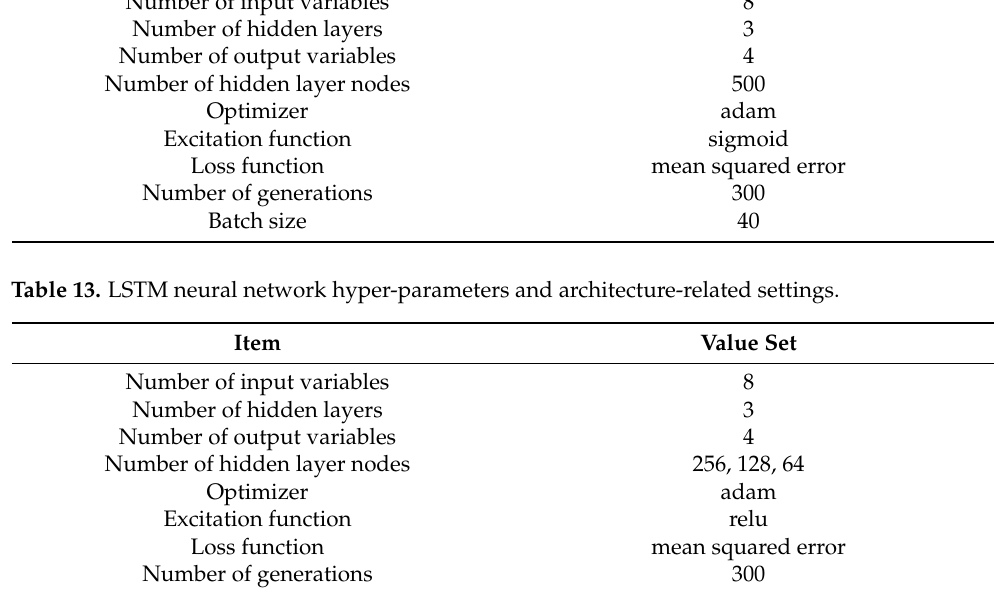
Table 12. FNN hyper-parameters and architecture-related settings. Item